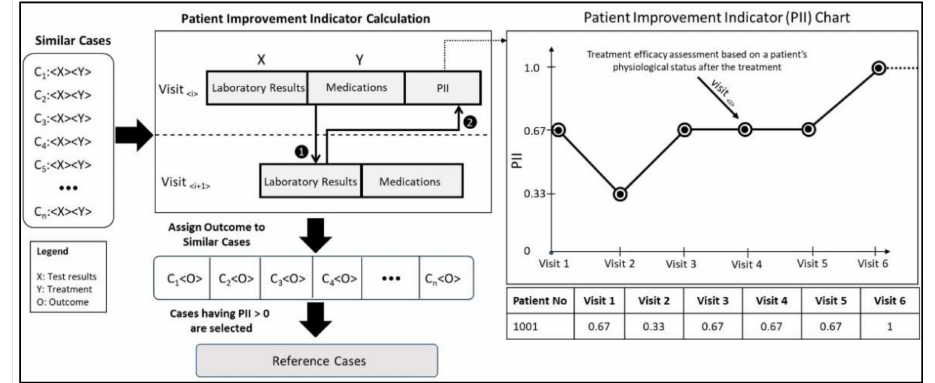
Figure 8. The Patient Improvement Indicator (PII) for selecting reference